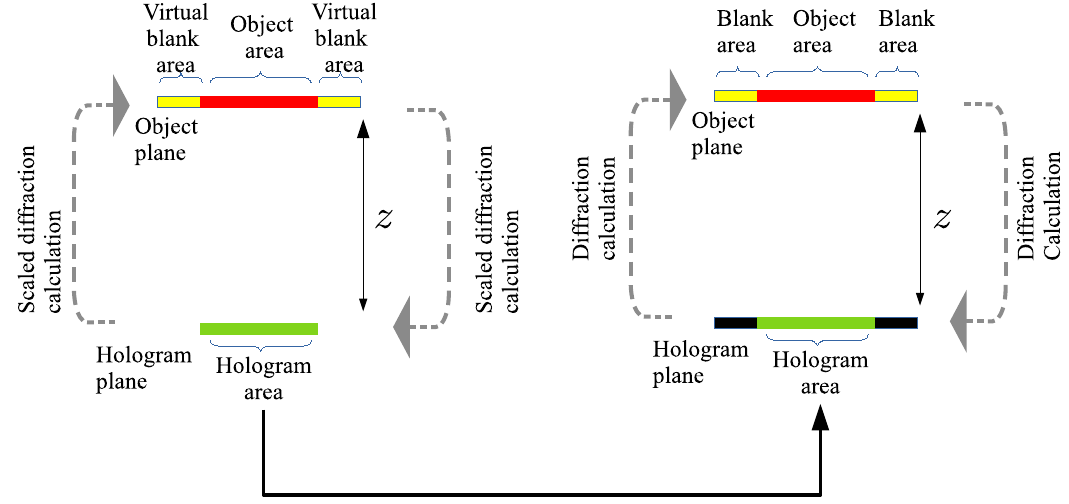
Figure 3. Combination